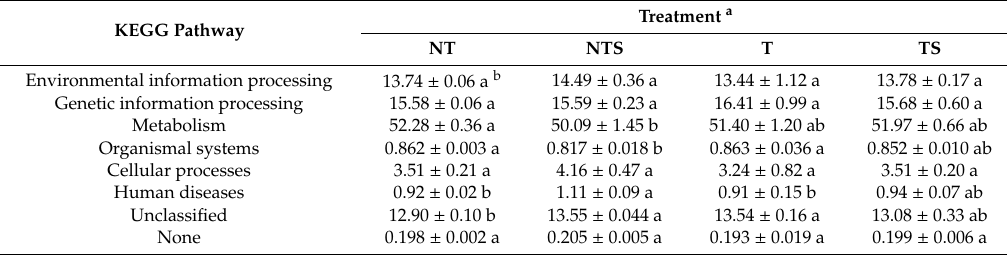
Table 2. Relative abundance of soil bacterial community predicted functions related to Kyoto encyclopedia of genes and genomes (KEGG) pathways at level one [32] as a ff ected by tillage and crop residue management treatments.